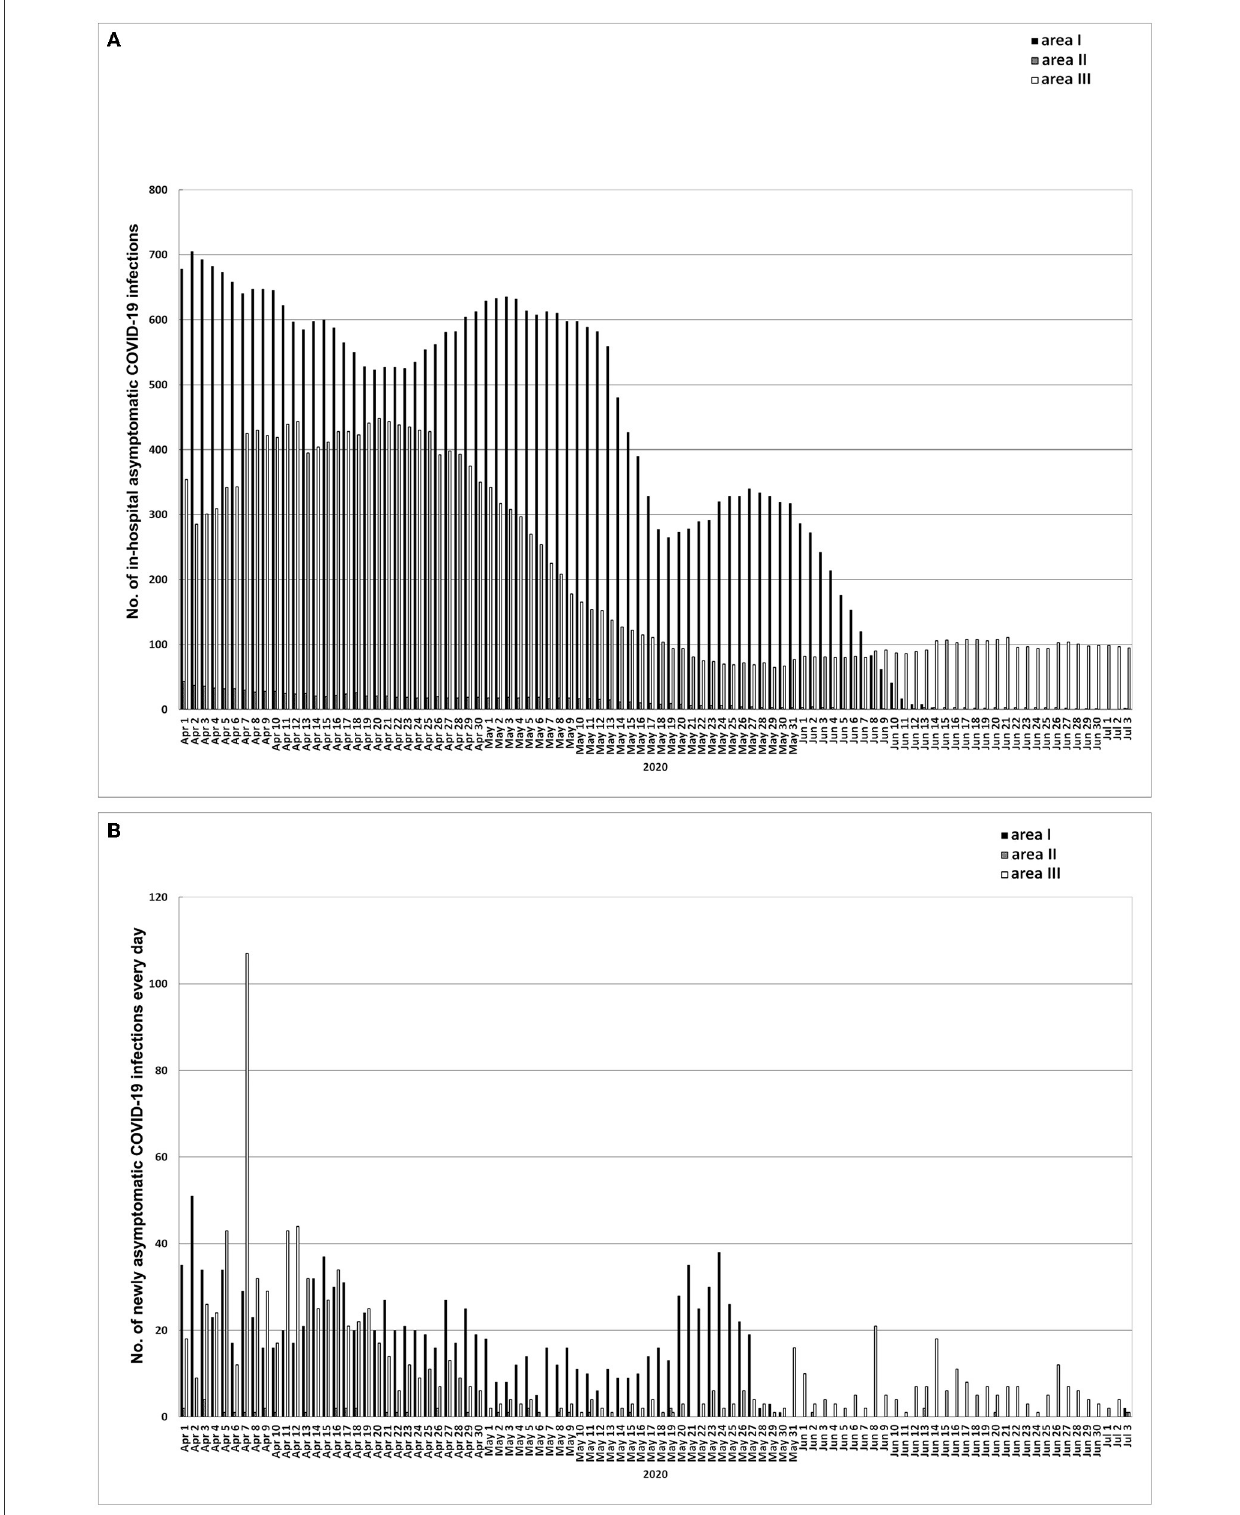
FIGURE5 Data of asymptomatic COVID-19 infections. (A) In-hospital asymptomatic COVID-19 infections updated daily in areas I, II, and III. (B) Daily increase of asymptomatic COVID-19 infections in areas I, II, and III. Area I, Wuhan city. Area II, Hubei province (excluding Wuhan city). Area III, Chinese mainland (excluding Hubei province). The data of asymptomatic COVID-19 infections could be obtained through the websites of health committees at all levels only after March 31,